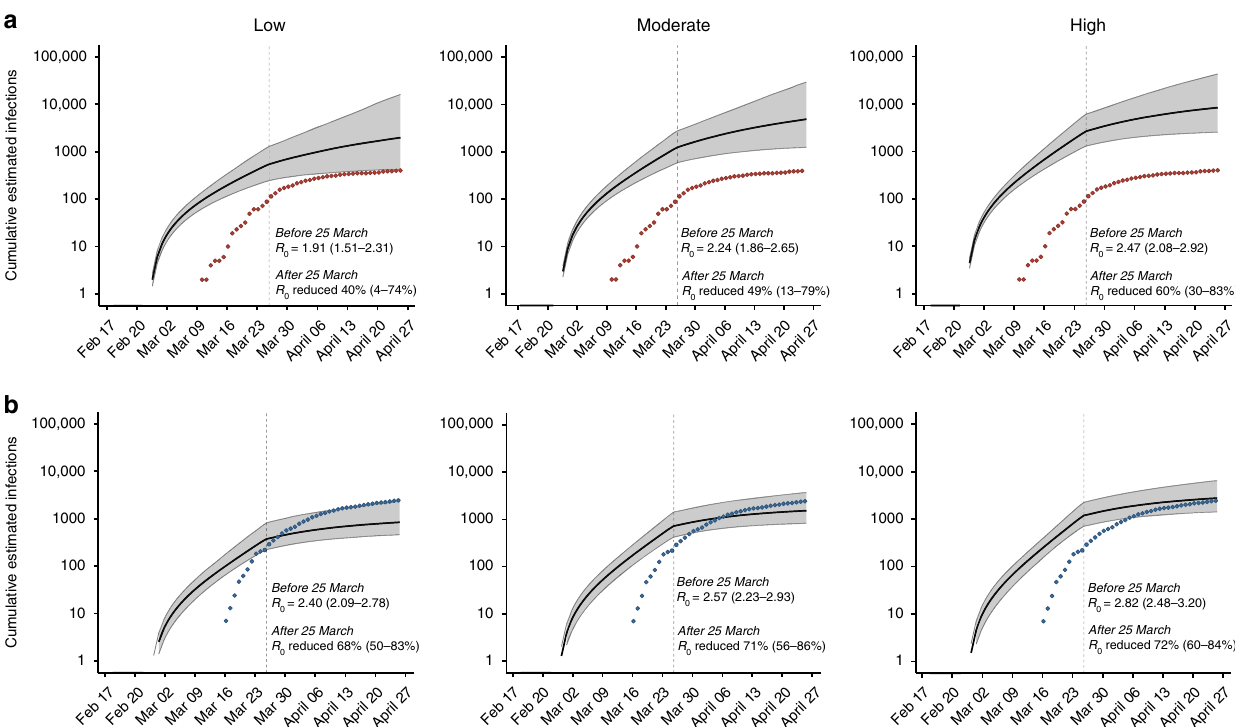
Fig. 5 Phylodynamic modeling of regional outbreaks informs regional outbreak dynamics before and after government interventions. Bayesian phylodynamic modeling of cumulative incidence up to 26 April for outbreaks in a Dane county and b Milwaukee county under low (left), medium (center), and high (right) transmission heterogeneity conditions. Model parameters for low, medium, and high transmission heterogeneity were fi xed such that 20%, 10%, and 5% of superspreading events contribute 80% of cumulative infections, respectively. Median cumulative incidence (solid black line) is bound by the 95% con fi dence intervals (CI; gray ribbon). Dots represent reported cumulative positive tests in Dane county (red) and Milwaukee county (blue). Estimated median reproductive numbers ( R 0 ) with 95% HDI are listed for the period before the Wisconsin “ Safer at Home ” order was issued on 25 at least 3 million states in BEAST2 (see “ Methods ” for more details). Source data to replicate this fi gure can be found in the Source Data fi